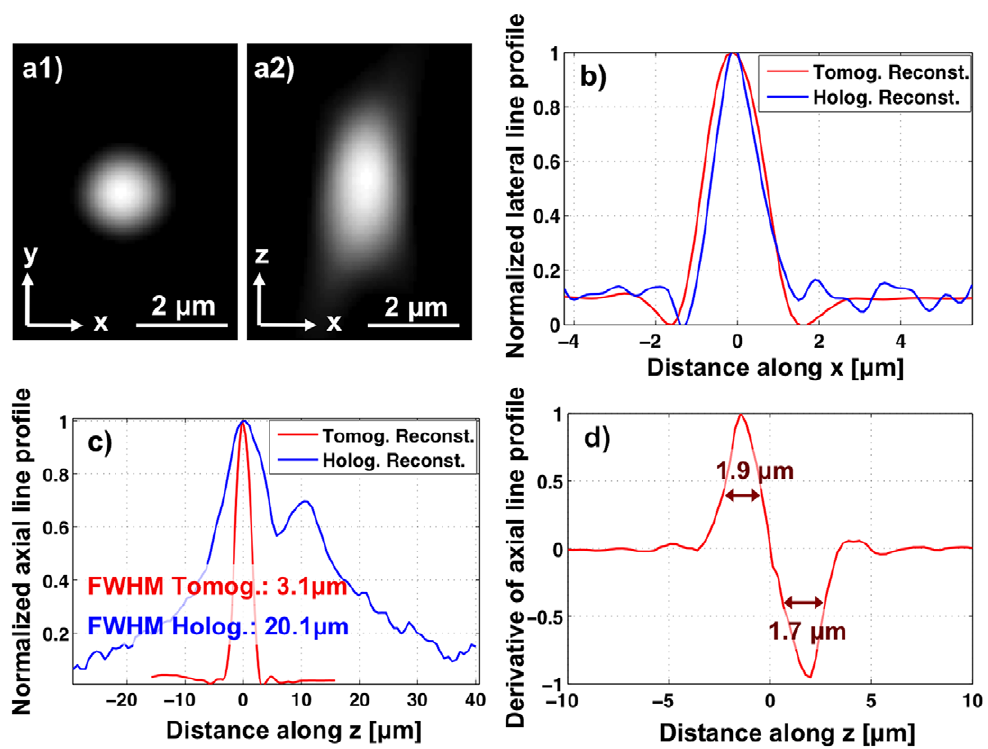
Figure 4. Lensfree imaging results demontrating , 2 m m axial resolution. (a1) Shows a tomogram in the x-y plane (lateral slice image) through the centre of a micro-particle having a diameter of 2 m m. (a2) Shows a tomogram in the x-z plane (ortho-slice image). The axial elongation is a manifestation of the limited angular range used in our tomographic reconstruction. (b) Shows line profiles along the x direction through the centre of the micro-particle’s tomographic (red curve) and holographic images (blue curve). (c) Shows axial line profiles through the centre of the micro- particle’s tomographic (red curve) and holographic images (blue curve). The significant improvement in axial resolution can be observed, as the FWHM of the axial line profile after tomographic reconstruction is much smaller. (d) Shows the derivative of the tomographic axial line profile in (c). Based on this edge response result, an axial resolution of , 2 m m can be estimated.